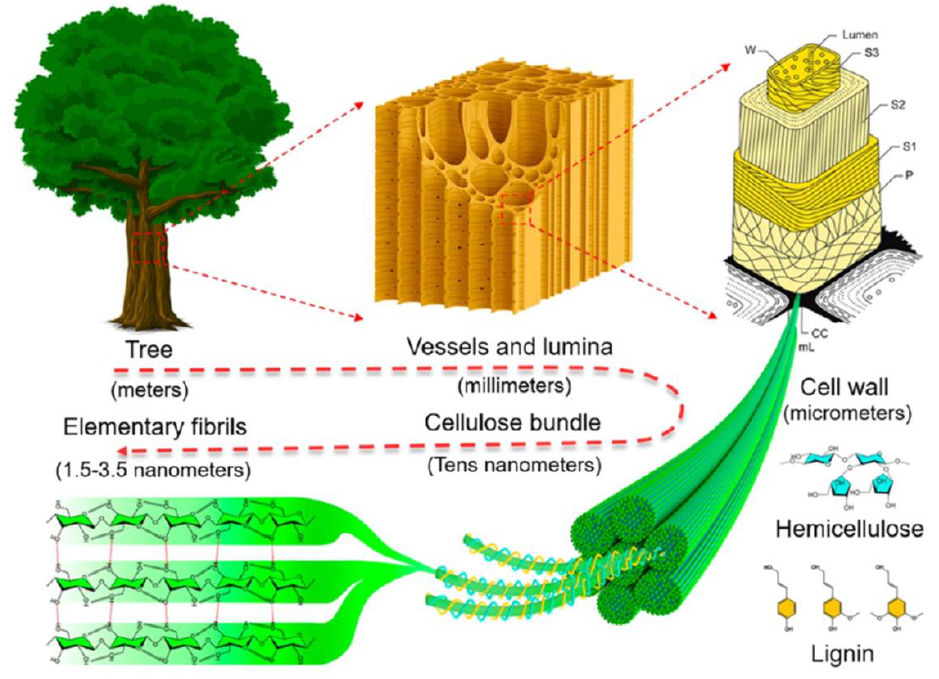
Figure 5. Schematic illustration of hierarchical structure of wood, from macroscopic to molecular level. Reprinted with permission from ref. [71]. 2018 American Chemical Society.